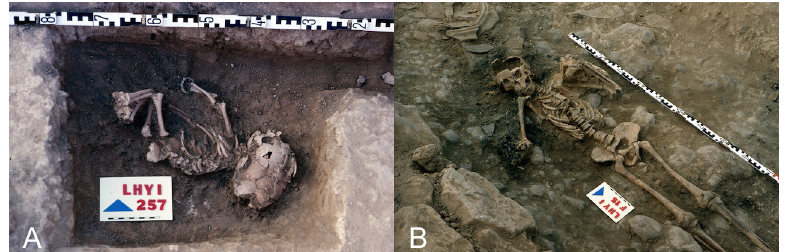
Fig 2. Human skeletal remains of an infant (A) and an adult individual (B) found in La Hoya archaeological